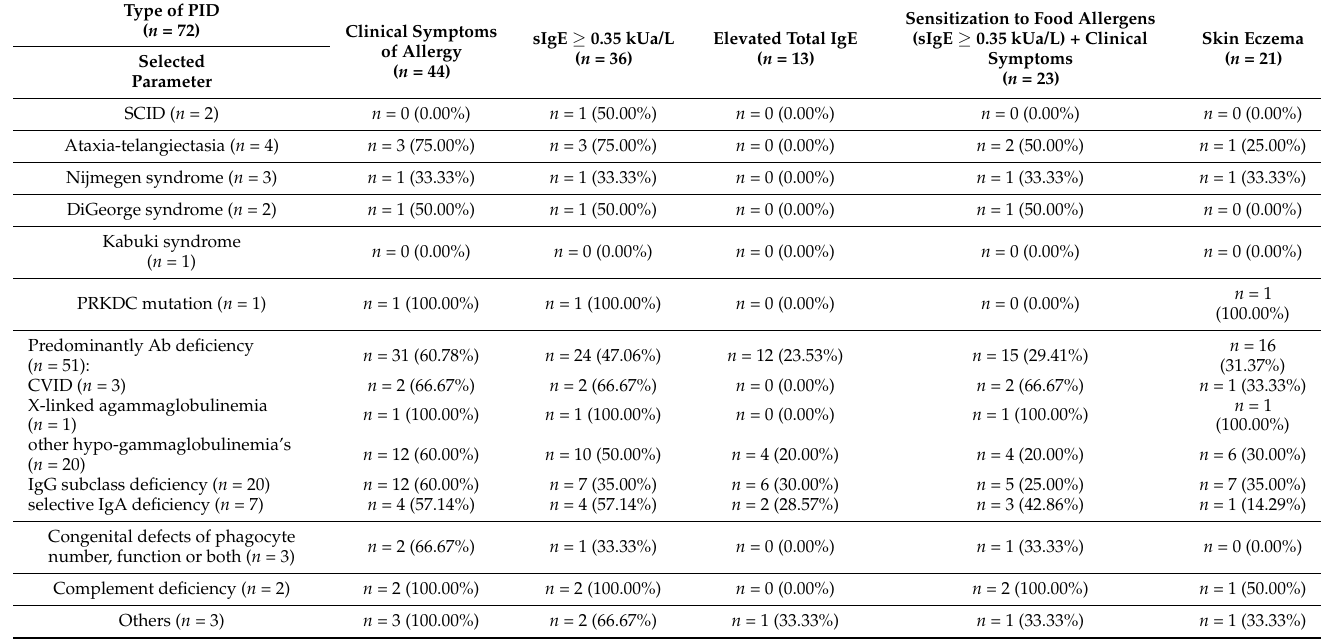
Table 2. Prevalence of sensitization to food allergens, skin eczema, clinical symptoms of allergy, elevated total IgE and sIgE levels in the recruited patients with